Question: Express in one sentence what the figure is showing.
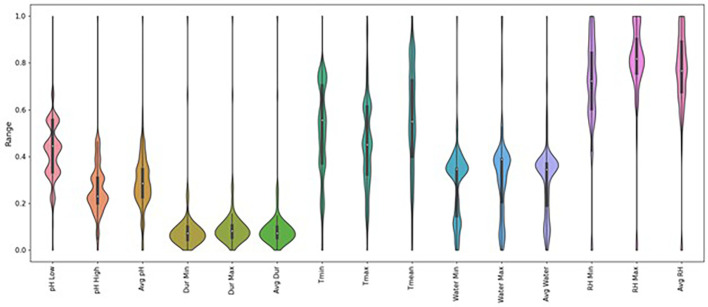
Answer: Input variable distribution.